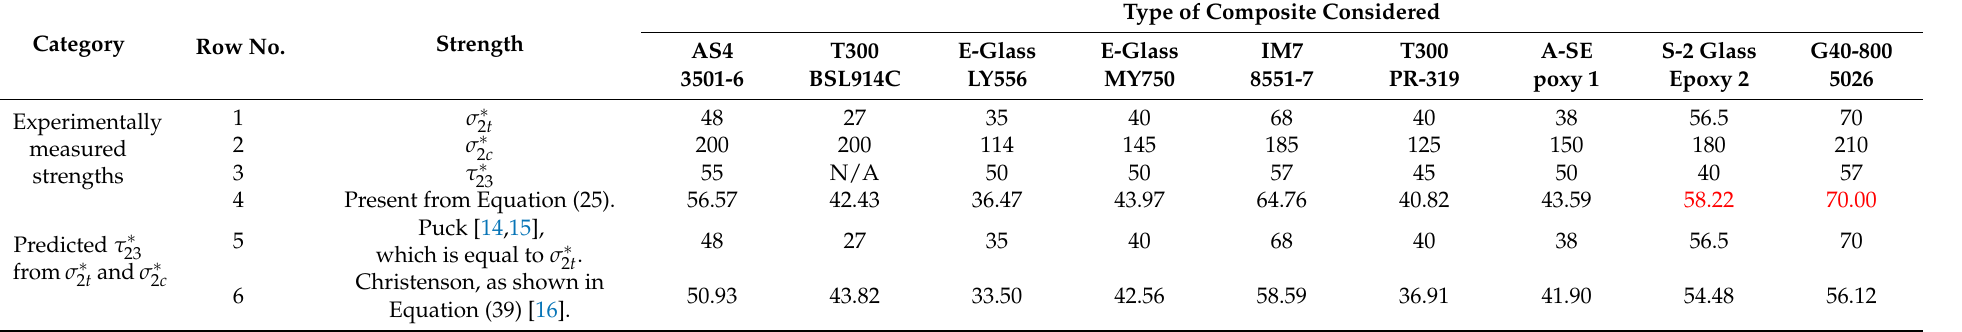
Table 1. Experimentally measured strengths and predicted transverse strengths according to different theories, all in